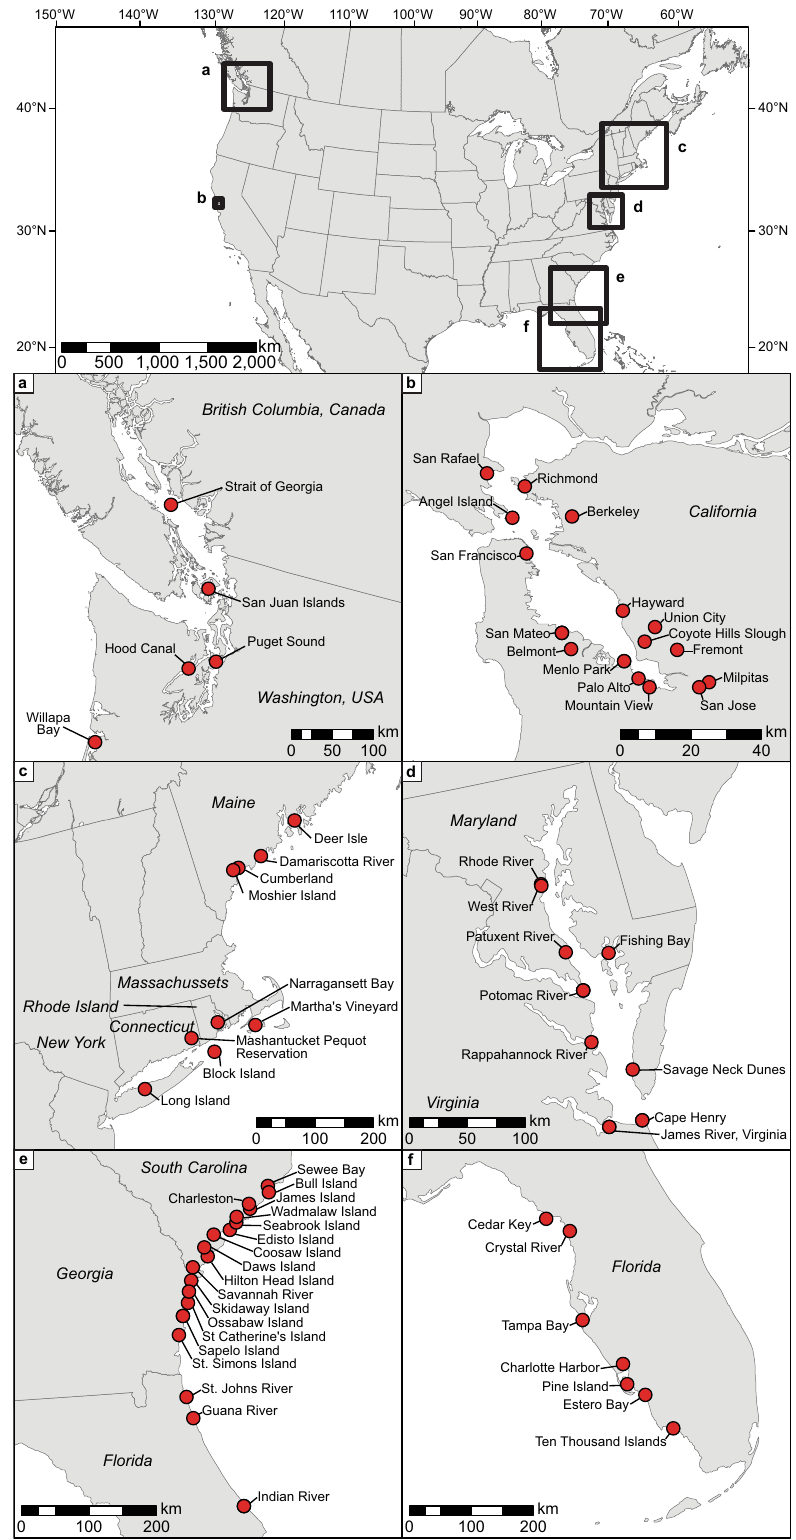
Fig. 2 Maps of North American study areas. Locations of oyster-bearing sites used in this study, including a The Paci fi c Northwest of North America, b San Francisco Bay, c New England, d Chesapeake Bay, e The Atlantic coast of the southeastern US, and f The Peninsular Gulf Coast of Florida. Red circles represent more speci fi c locations and correspond to site locations in Supplementary Data